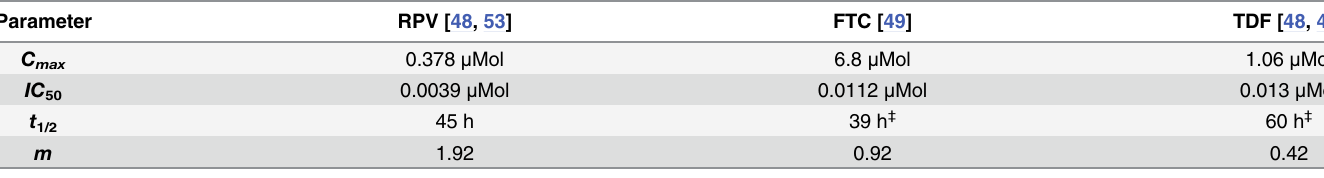
Table 7. PK/PD modeling parameters for RPV, FTC and